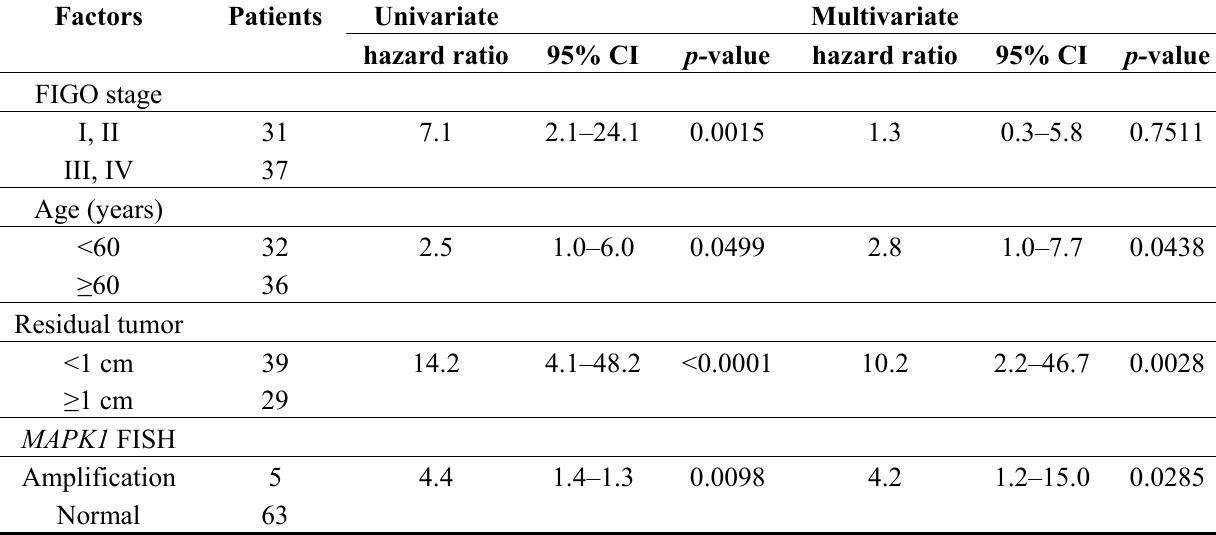
Table 3. Univariate and multivariate analysis of progression-free prognostic factors in patients with type II ovarian